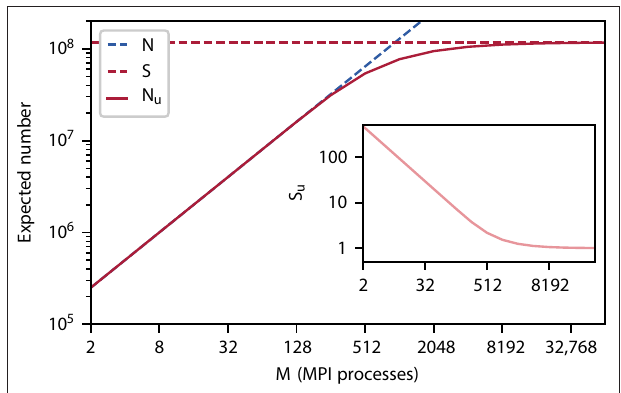
FIGURE 1 | Expected number of unique source neurons N u (pink curve) of all thread-local synapses as a function of the number of the MPI processes M assuming T = 12 threads and 125,000 neurons per MPI process in a weak-scaling scenario; the total number of neurons N (dashed blue curve) and number of thread-local synapses S (dashed pink horizontal line for K = 11,250 synapses per neuron). Inset: Expected number of thread-local synapses per unique source neuron S u = S / N u (light pink curve). All graphs in double logarithmic